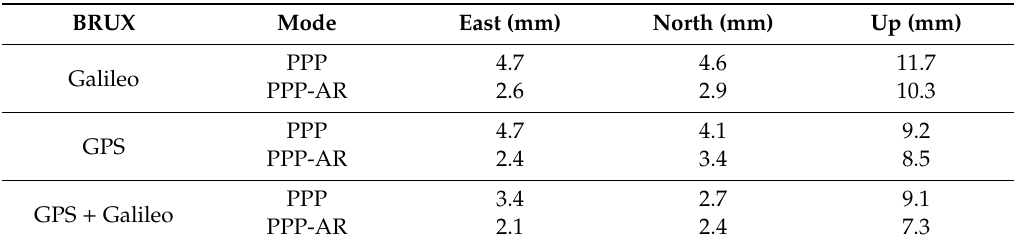
Table 4. 1- σ values PPP and PPP-AR for BRUX station.